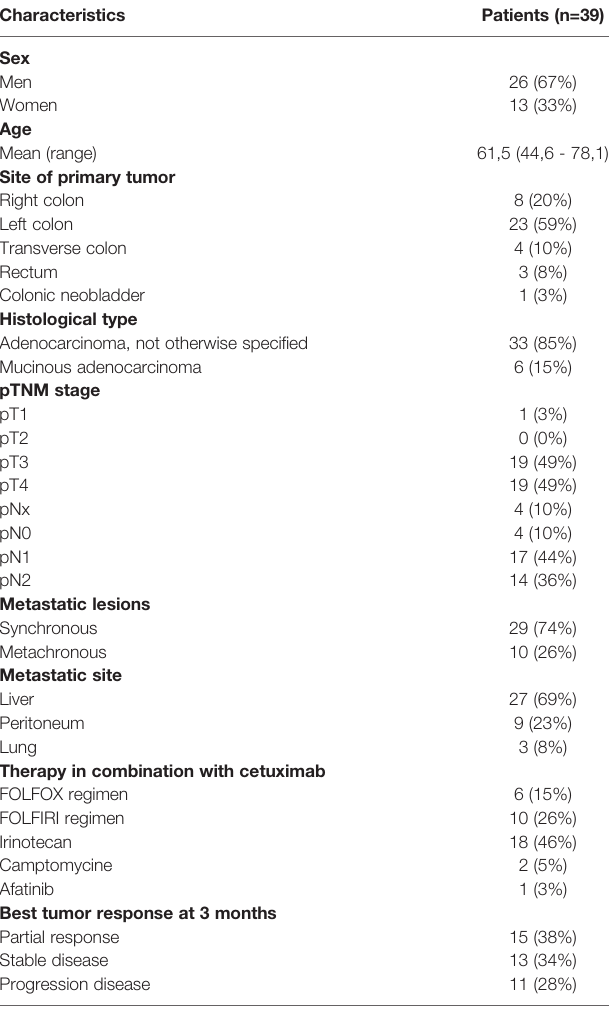
TABLE 1 | Clinicopathological features of mCRC patients treated with cetuximab in combination with chemotherapy. Characteristics